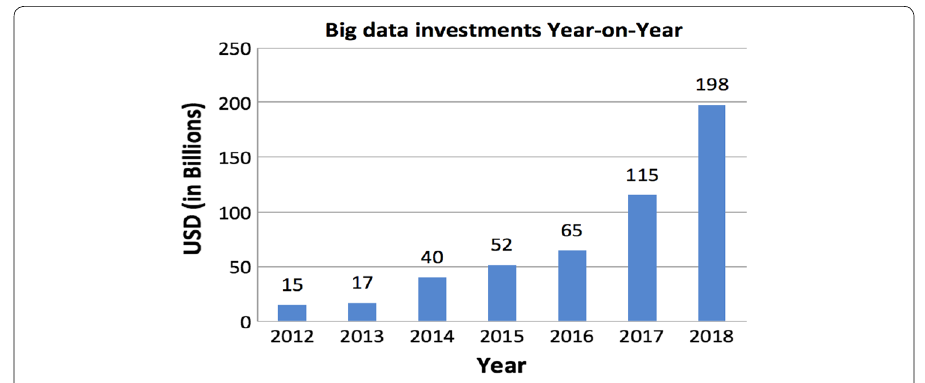
Fig. 4 Big data investments between 2012 and